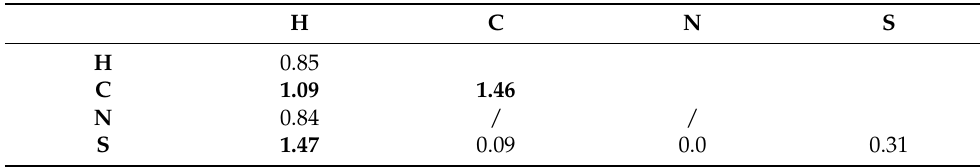
Table 3. Enrichment ratios E calculated from the fingerprint plot in Figure 3 using the algorithm of [22]. Values larger than unity are printed in bold. Entries where no reliable value could be obtained are marked with